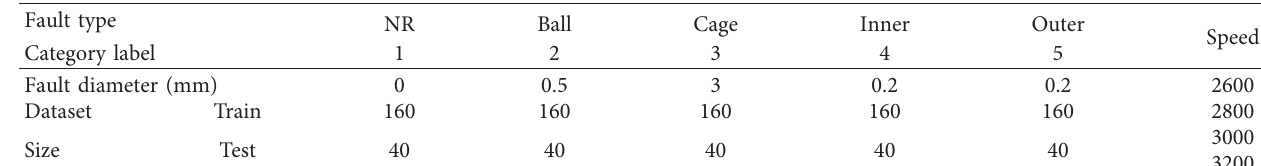
Figure 13: The faults of bearing in four locations: (a) inner fault; (b) outer fault; (c) fix fault; (d) ball fault. Table 6: Description of the measured datasets.